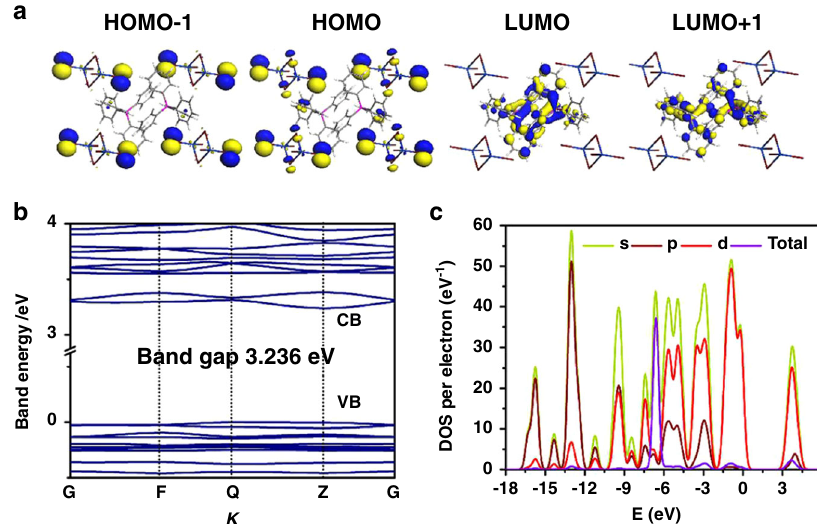
Fig. 5 Density functional theory (DFT) calculations of (Ph 4 P) 2 Cd 2 Br 6 . The calculated molecular orbitals a HOMO-1, HOMO, LUMO, and LUMO + 1. Band structures around the Fermi energy level b and the total/partial electronic density of states c for (Ph 4 P) 2 Cd 2 Br 6 . G (0, 0, 0), F (0, 1/2, 0), Q (1/2, 0, 0), and Z (0, 0, 1/2) are the selected reciprocal points in the fi rst Brillouin zone (BZ).